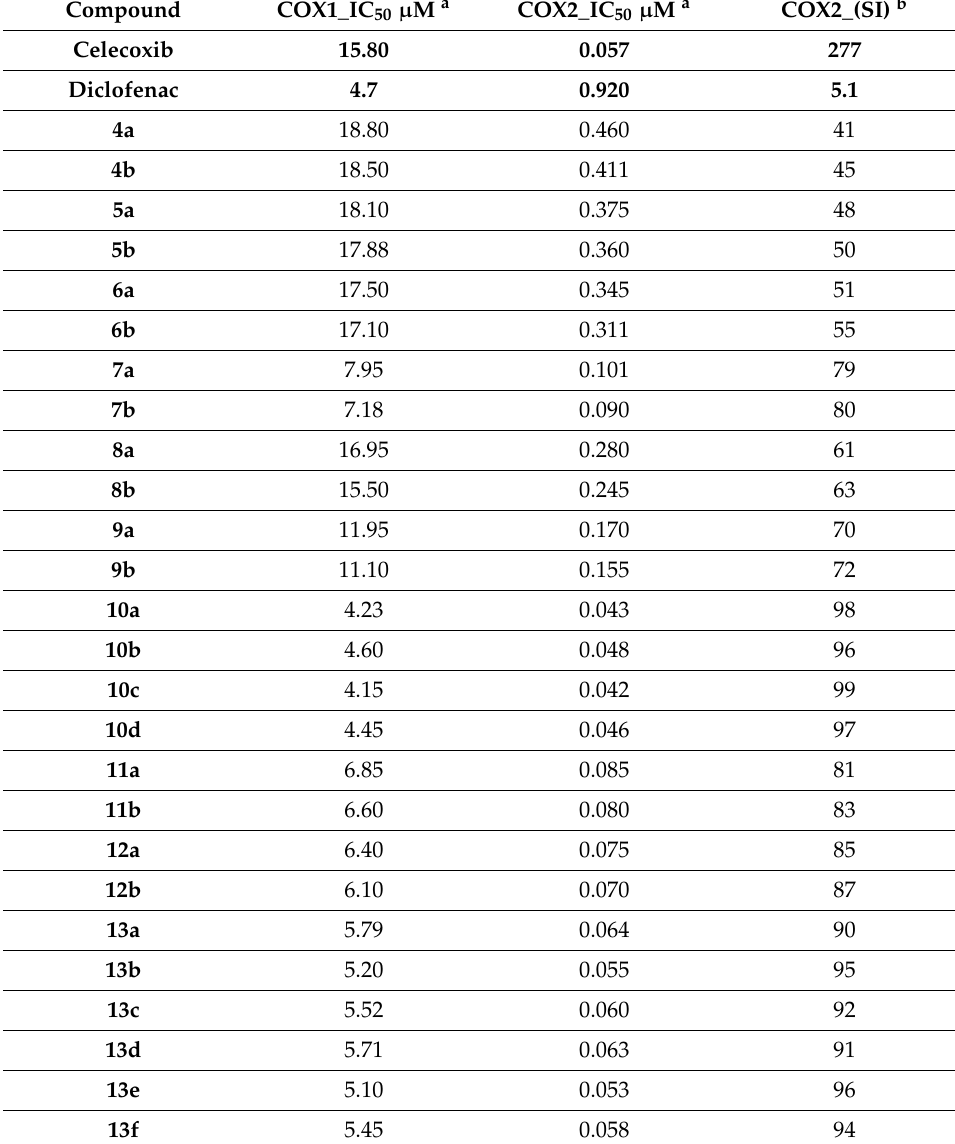
Table 1. IC 50 and selectivity index values of the